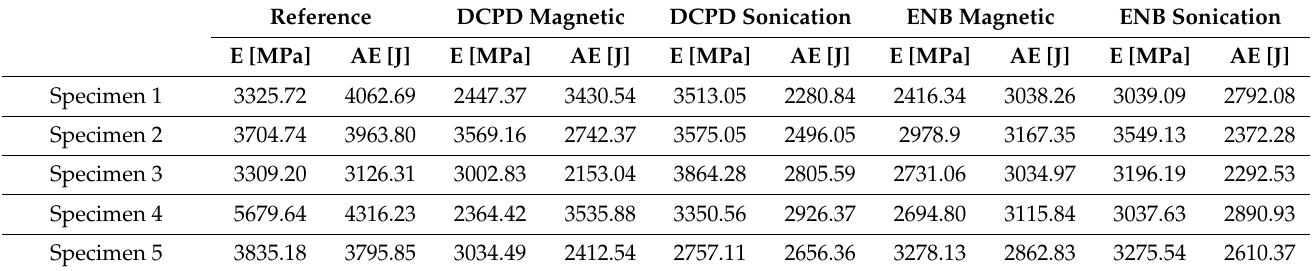
Table 7. Three-point bending flexural modulus and absorbed energy results.